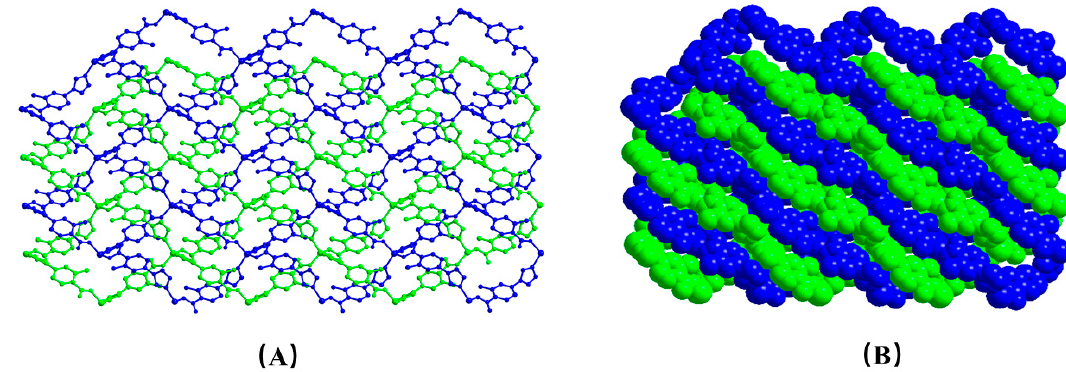
Figure 3. ( A ) The system of 2D + 2D → 2D parallel interpenetration in 1 (left); ( B ) Space-filling projection of parallel interpenetrated nets of 1 (right).